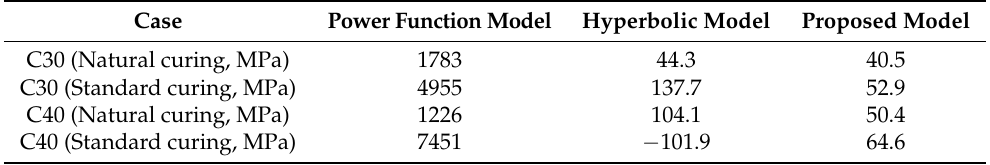
Table 3. Predicted compressive strengths of concrete with 28 days by the three